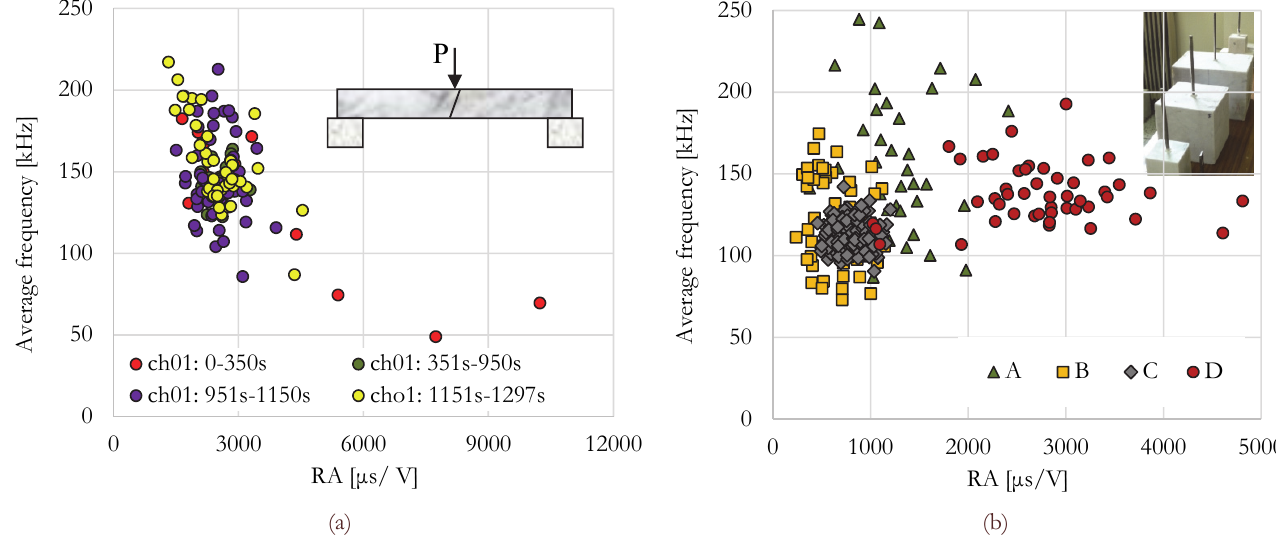
Figure 13: (a) The variation of the average frequency of the acoustic signals against the respective RA for the four time intervals considered; (b) The variation of the average frequency of the acoustic signals against the respective RA for a typical pull-out test [11], for four time intervals (A is the first and D the last one)